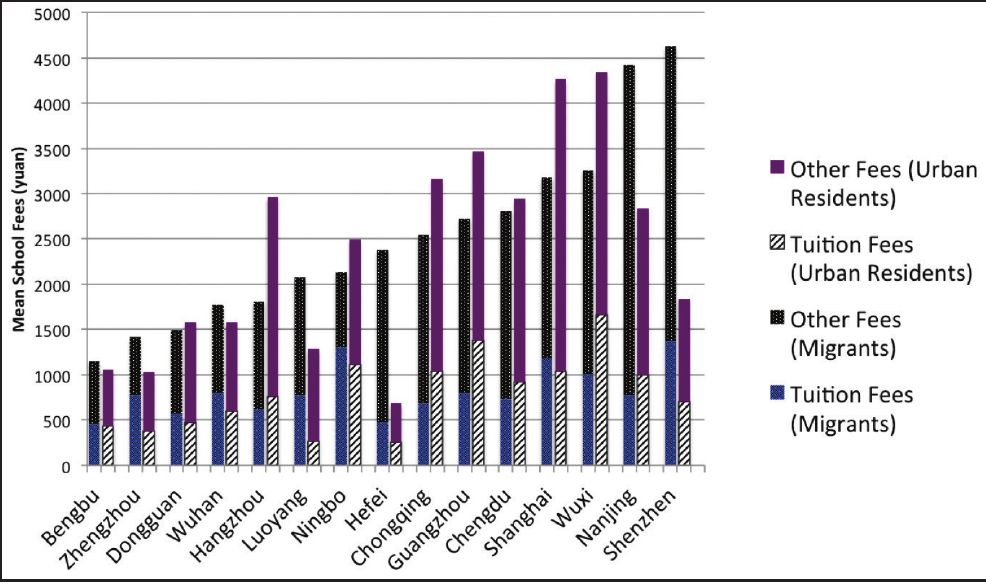
School fee decomposition for migrants and urban